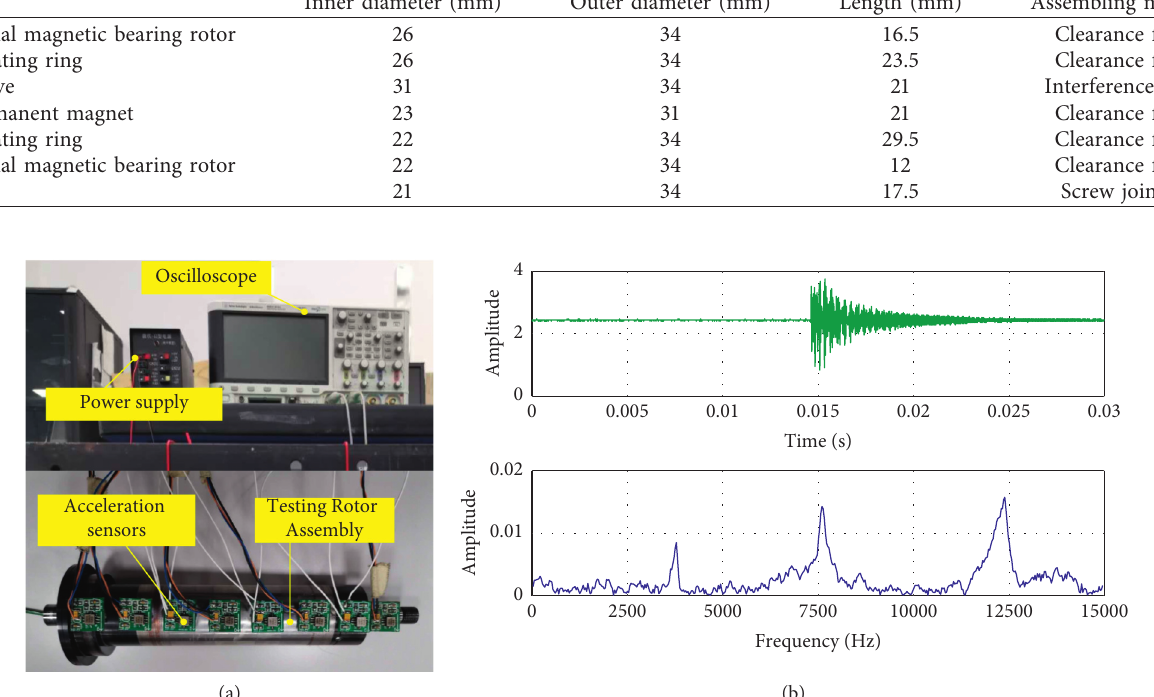
Figure 13: The modal test. (a) The test setup, and (b) the results of the modal test.